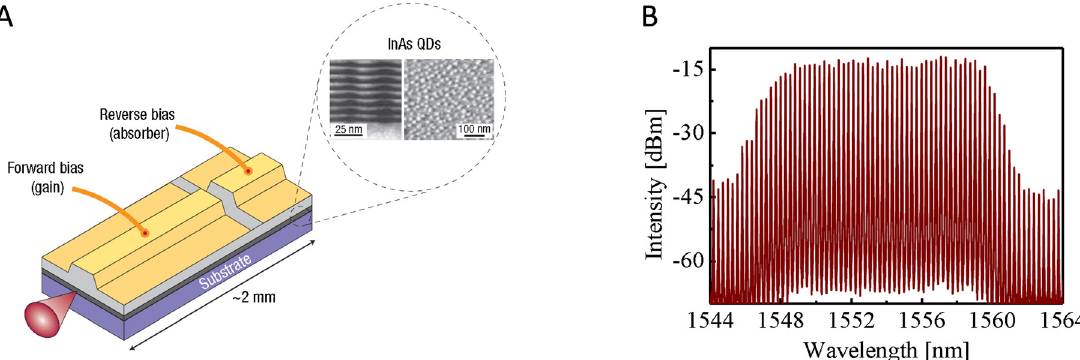
Figure 4: An integrated device and a MLL-based frequency comb. (A) Schematic of chip-based passive mode-locked laser with integrated gain and absorber, (inset) TEM photographs of quantum dots layers [28]. (B) Optical spectrum of a QD-MLL-based frequency comb [30]. Reprinted with the permissions from Ref. [28] Copyright 2007, Springer